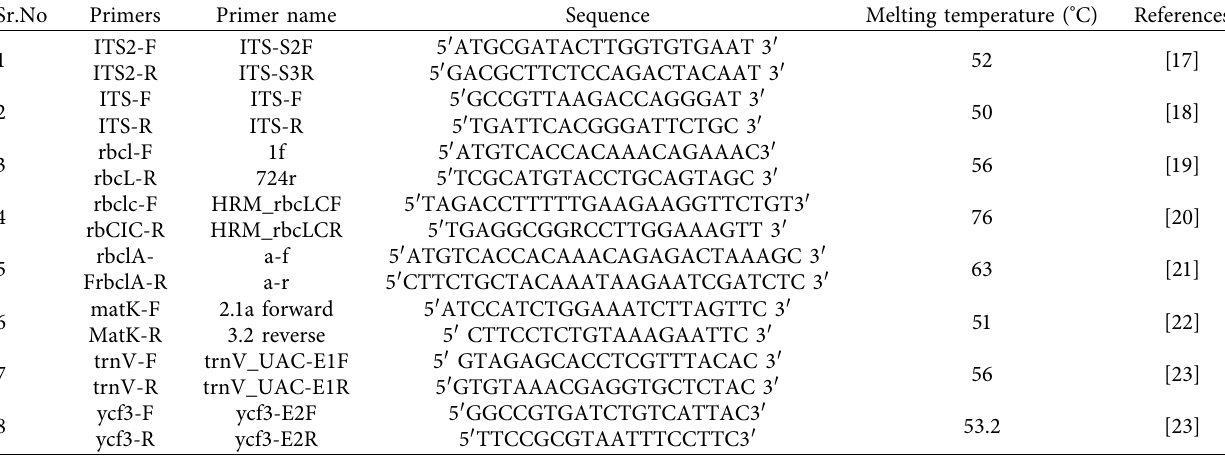
Table 2: Conditions of the selected markers and their sequences used in the current molecular study. Sr.No